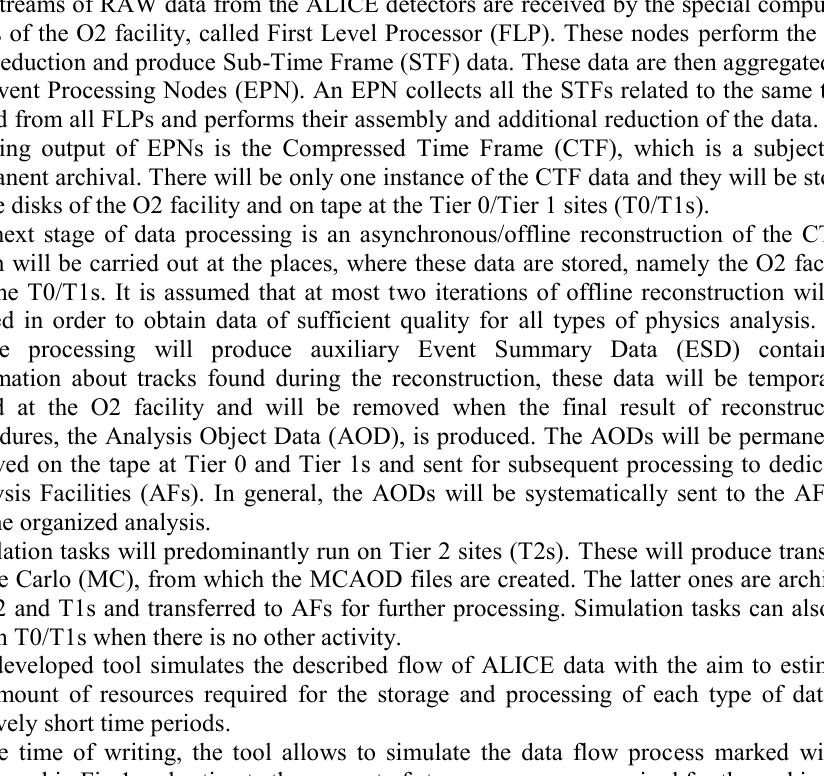
Fig. 1. Data flow in the ALICE Computing Model for Run 3 and Run 4.